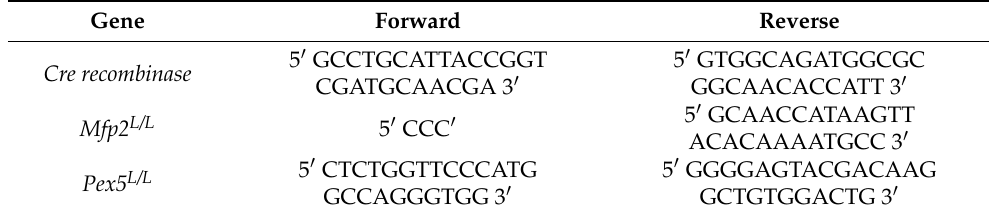
Table 1. List of primers used for PCR